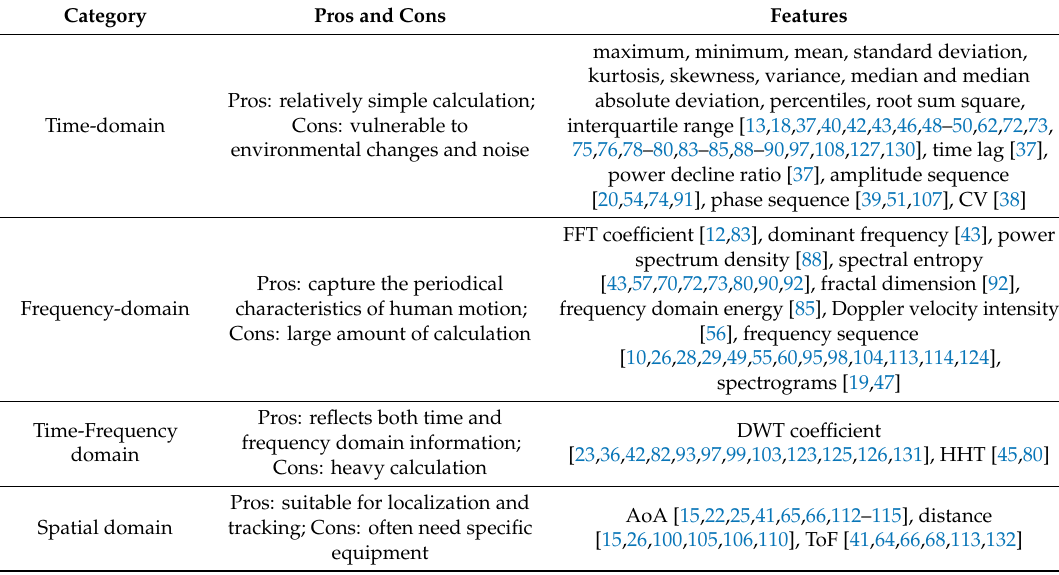
Table 7. Summary of